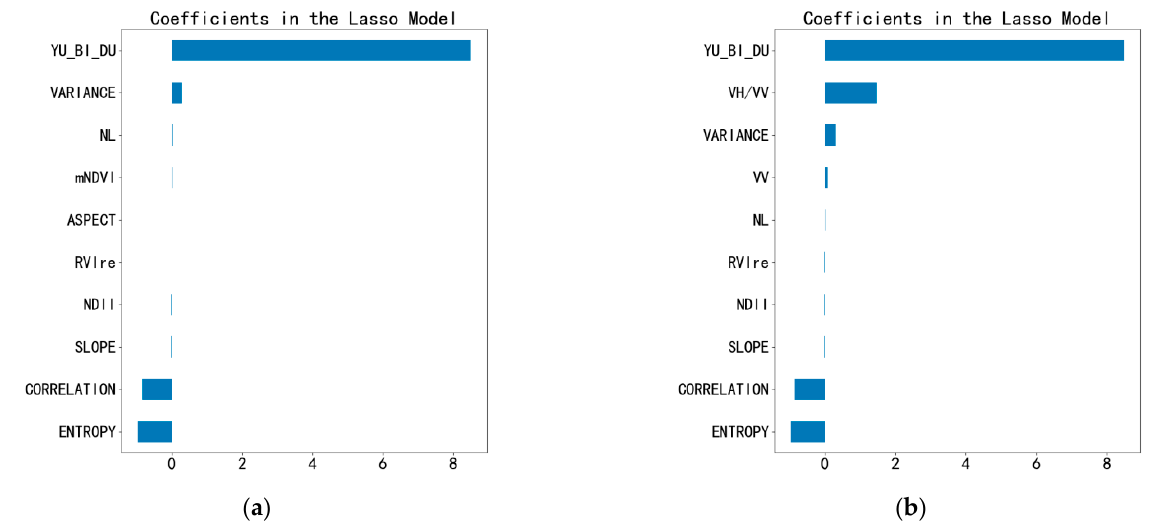
Figure 4. Importance of the independent variables calculated by Lasso.